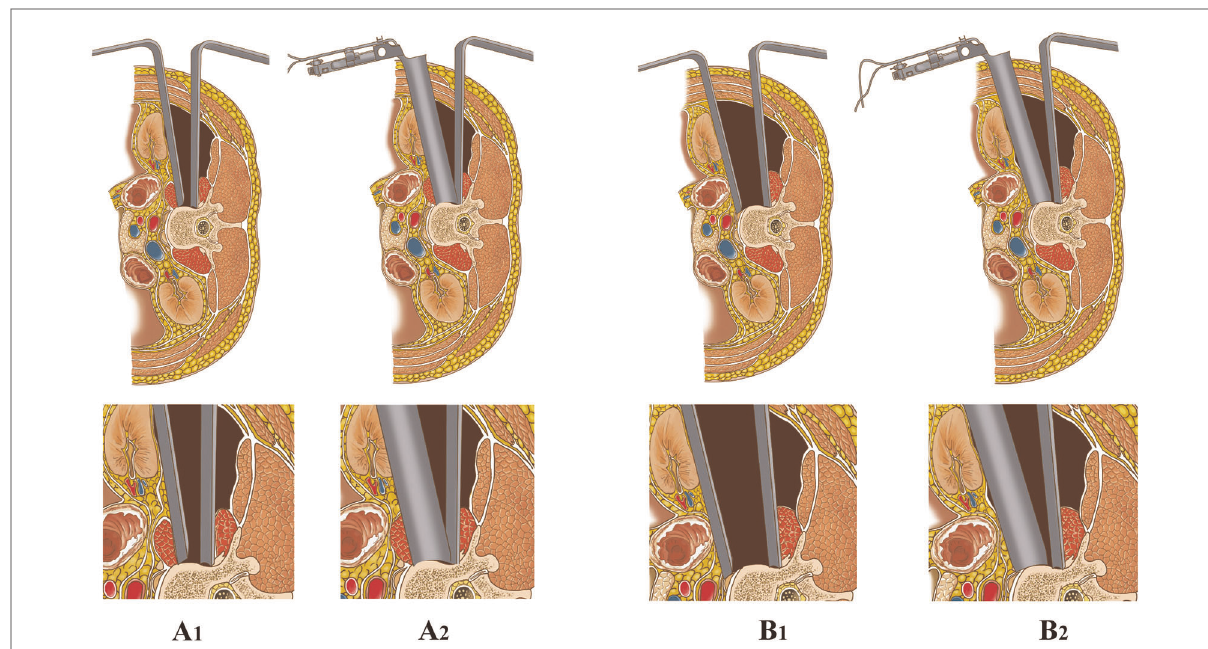
FIGURE 1 Two techniques for placement of anterior retractors via a mini-open incision. ( A 1 − 2 ) LTPA : The psoas was identi fi ed and bluntly split along the direction of the muscle fi ber using a blunt-split device. Then, the retractor system was placed and fi xed to the superior and inferior segments of the fractured vertebra. ( B 1 − 2 ) AIPA : Psoas muscle was retracted posteriorly from the border of the psoas; then, the retractor system was placed obliquely, then turned laterally and fi xed to the superior and inferior segments of the fractured